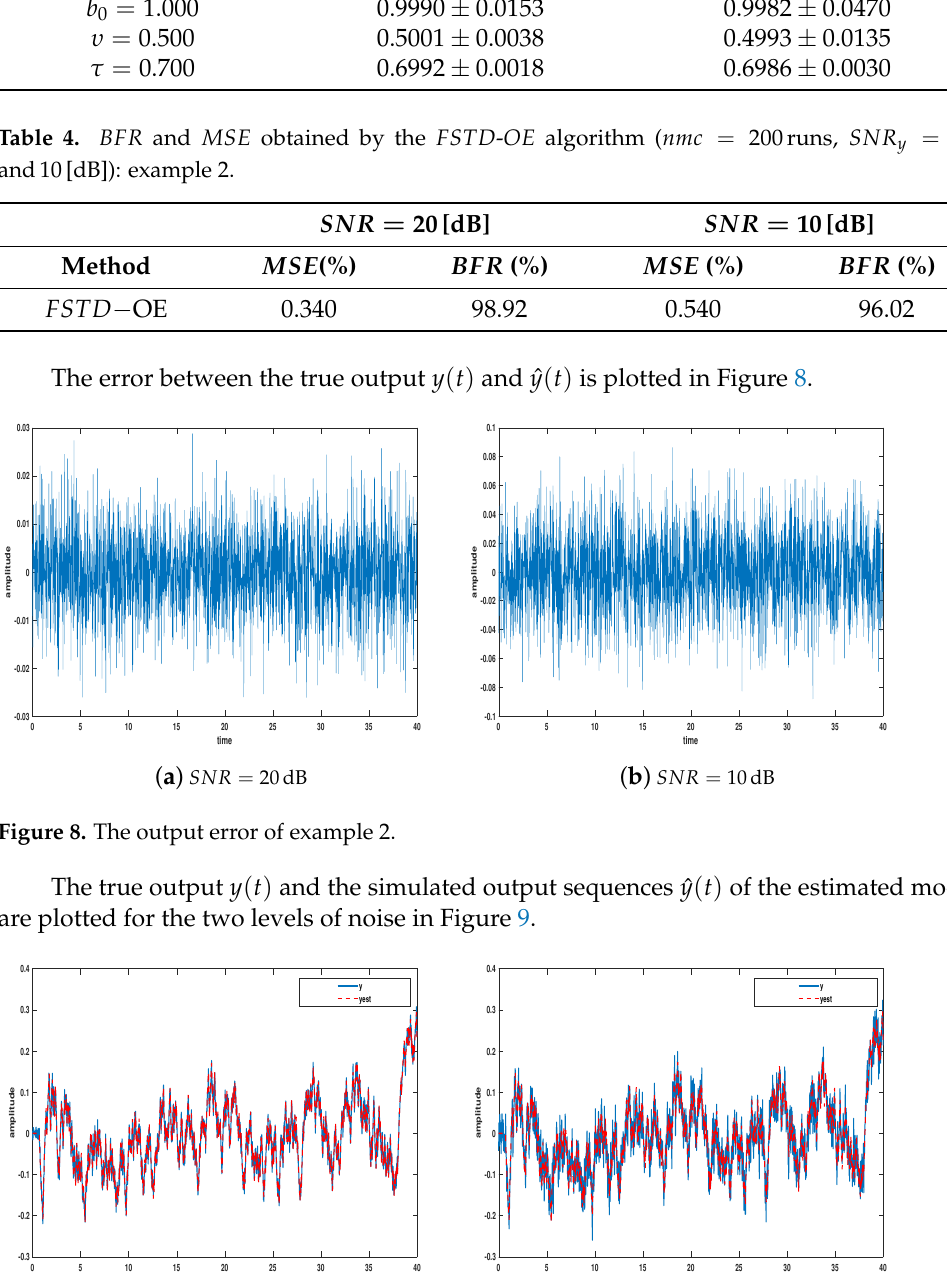
Figure 9. The true and the estimated output signals of example